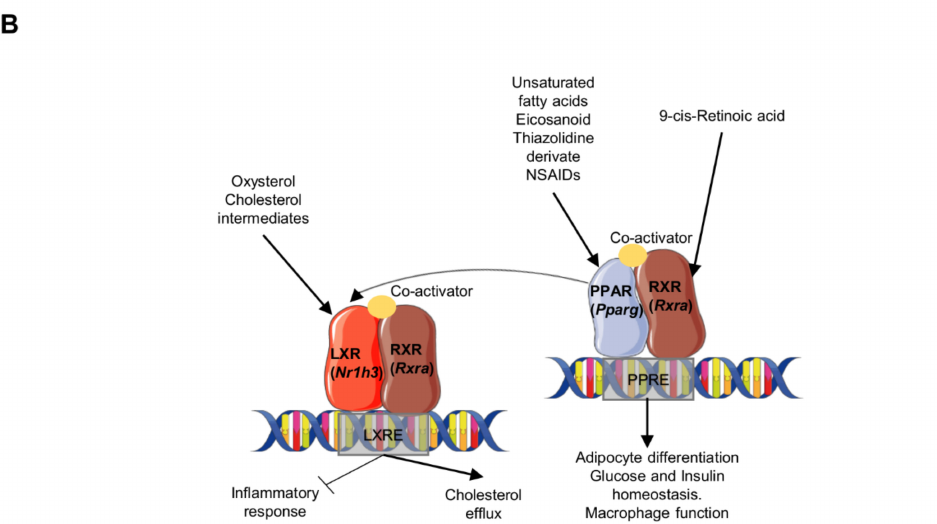
Figure 5. Downregulation of transcriptional factors involved in lipid metabolism and inflammation: ( A ) mRNA expression of genes at 1, 3, 5, and 10-days post infection, expressed as Log 2 of expression fold-change. Statistically significant differences between non-infected (control) and infected animals are indicated (* p < 0.05; ** p < 0.01; **** p < 0.0001); ( B ) In the macrophage nucleus, Nuclear Receptors (NR’s) Peroxisome proliferator-activated receptors (PPARs) and Liver X receptors (LXRs) bind to specific response elements (PPAR response element (PPRE) or LXR response element (LXRE)) in target genes as heterodimers with retinoid X receptors (RXRs). Activation of these NRs results in transrepression of proinflammatory genes ( Nos2, Ptgs2 ) but activation of cholesterol efflux, adipocyte differentiation, glucose, and insulin homeostasis, among others. This signaling is activated by several molecules like 9-cis-retinoic acid, unsaturated fatty acids, eicosanoids, oxysterol, and cholesterol intermediates. In our model, the downregulation of nuclear receptors ( Pparg, Rxra, Nr1h3 ) was observed at some timepoints shortly after infection, consistent with the overexpression of proinflammatory markers observed as early as one day post infection